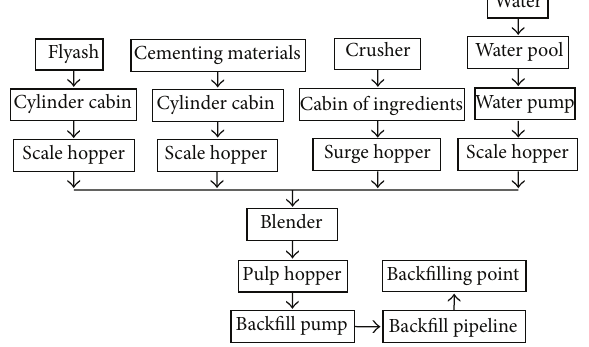
Figure 2: The paste backfill technological process.